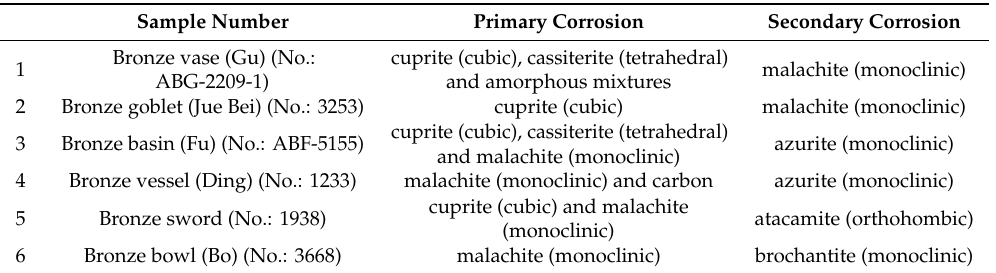
Table 2. Corrosion products on the surface of the six ancient bronzes. Sample Number Primary Corrosion Secondary